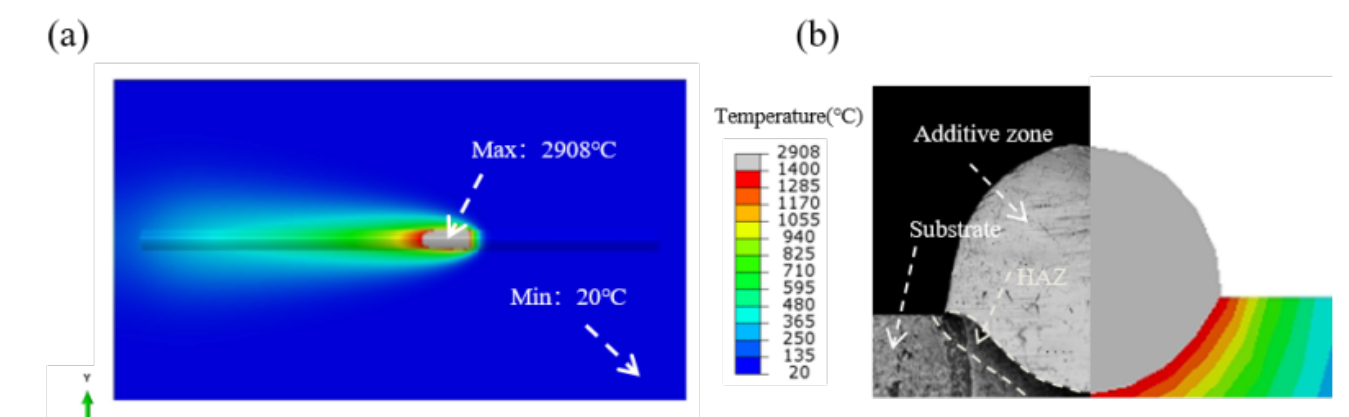
Figure 8. Calibration of the heat source model. ( a ) Temperature field distribution of a monolayer single pass. ( b ) Comparison of the cross-sectional shape of the actual additive formation and the simulated results.